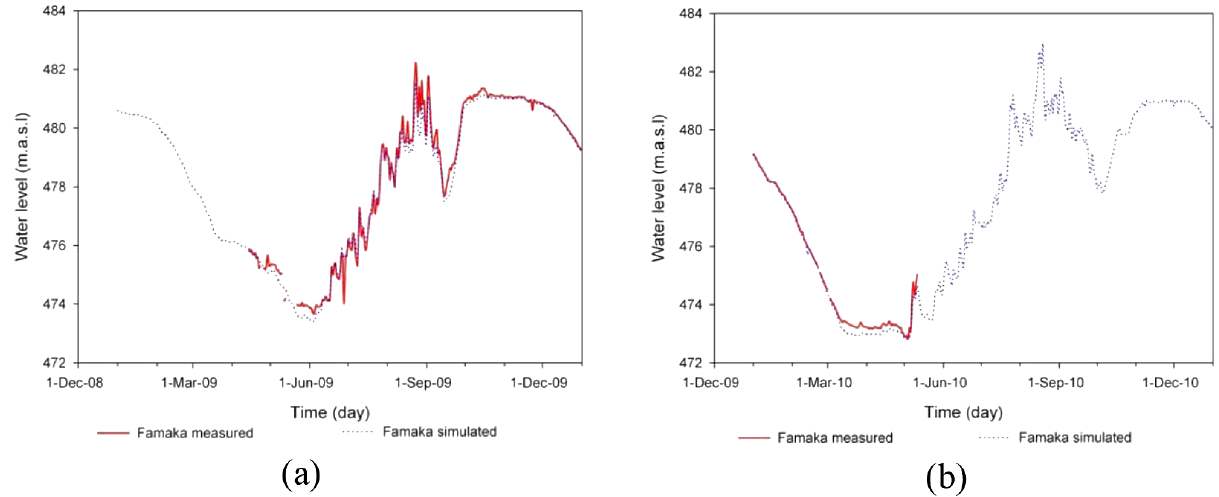
Figure 7. Results of hydraulic model calibration (a) and validation (b) : computed vs. measured water levels at Famaka (location in Fig. 2). Levels in ma.s.l. (irrigation datum).